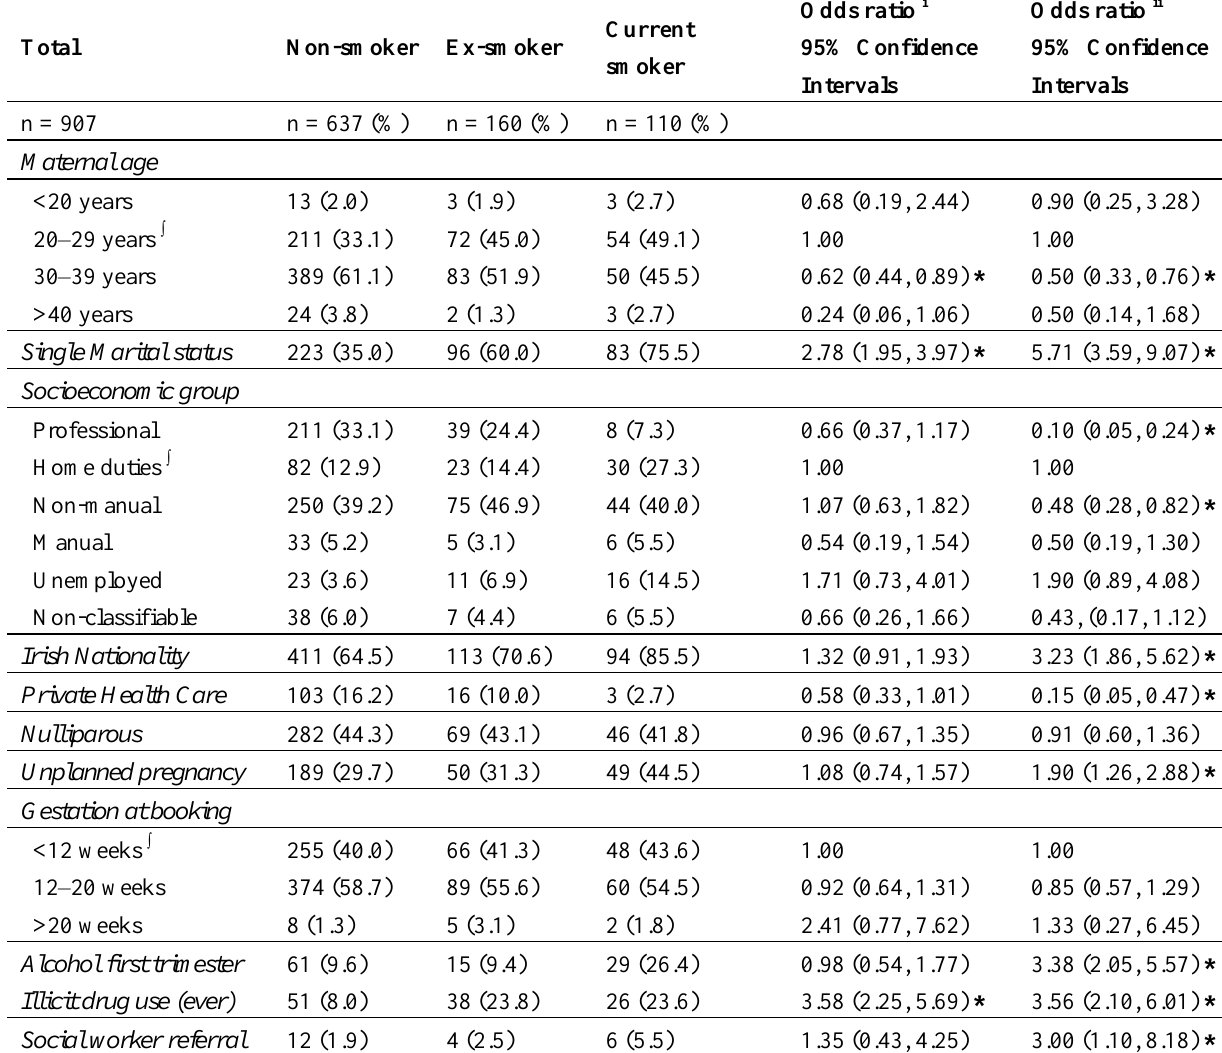
Table 3. Characteristics of women according to smoking in